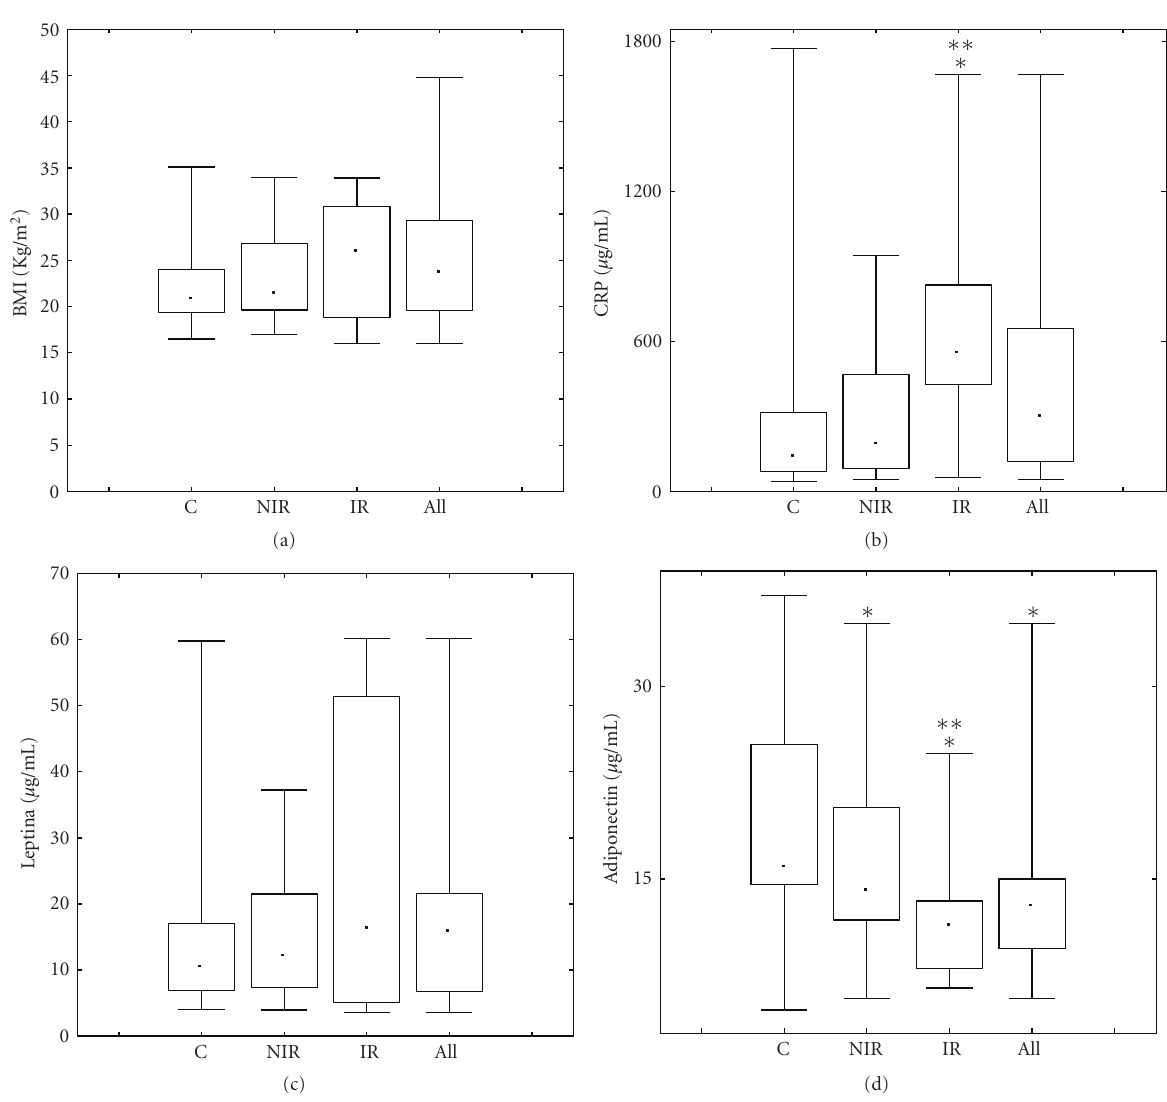
Figure 1: Leptin, BMI, adiponectin, and CRP in PCOS and control girls in controls (c), noninsulin resistant (NIR), and (IR) girls. Due to the strongly asymmetric distribution of data, the graph shows the median(middle bar), interquartile ranges (boxes), and min-max ranges (end bars). P < .005 by Mann-Whitney U test.